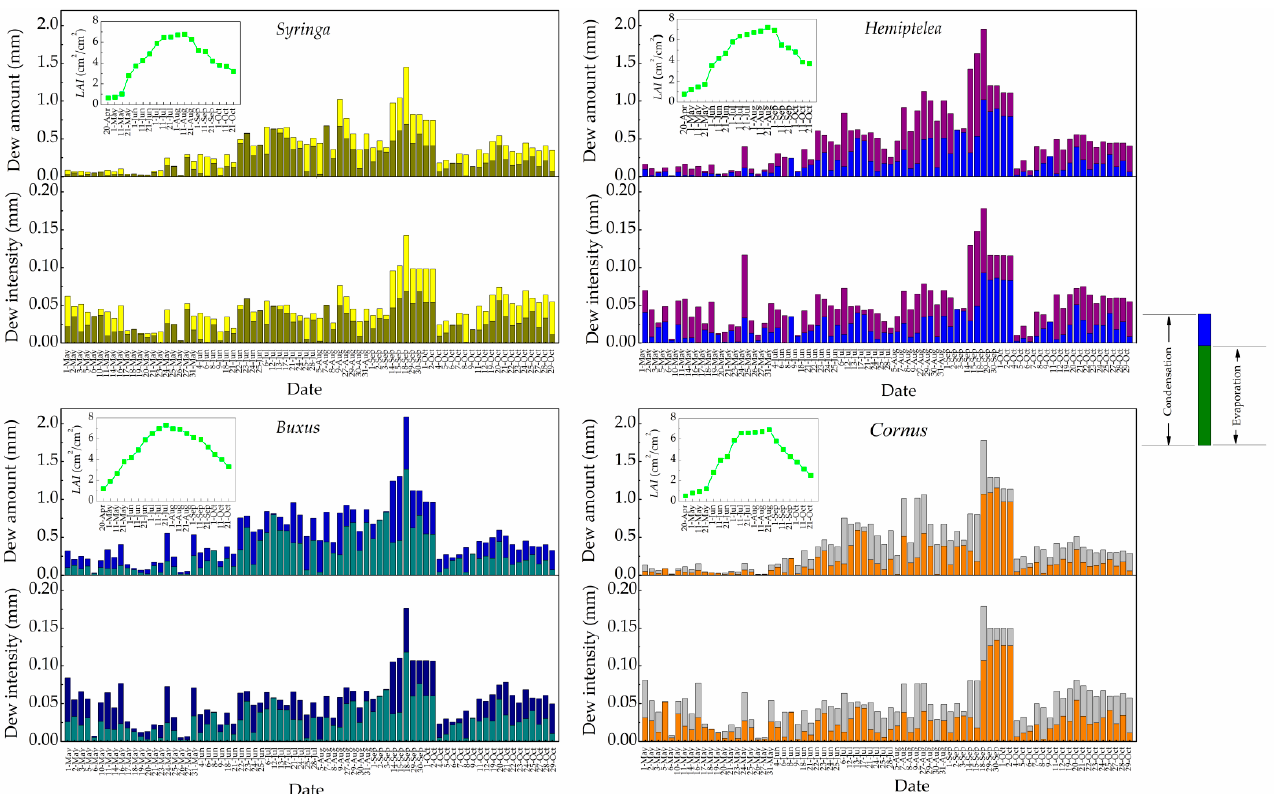
Figure 2. LAI s, daily dew evaporation intensities, and amount changes derived for different plants in the experimental period.